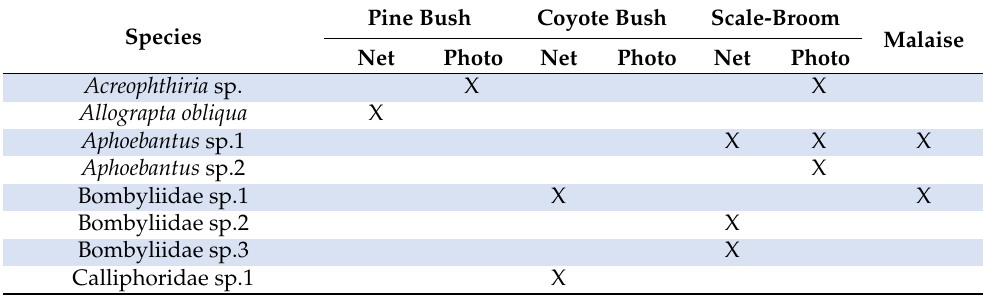
Table 7. Flies of E. pinifolia (pine bush), B. pilularis (coyote bush), and L. squamatum (scale broom). Pine Bush Coyote Bush Scale-Broom Species